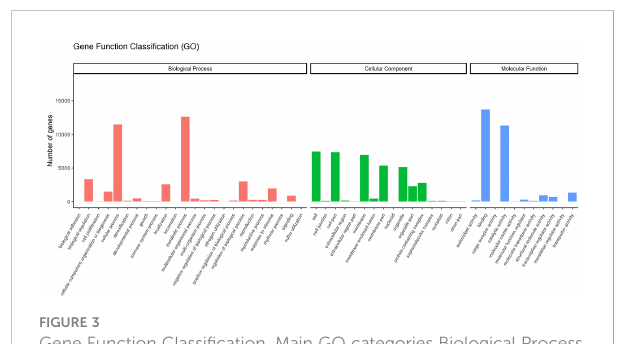
FIGURE 3 Gene Function Classi fi cation. Main GO categories Biological Process (BP), Cellular Component (CC), Molecular Function